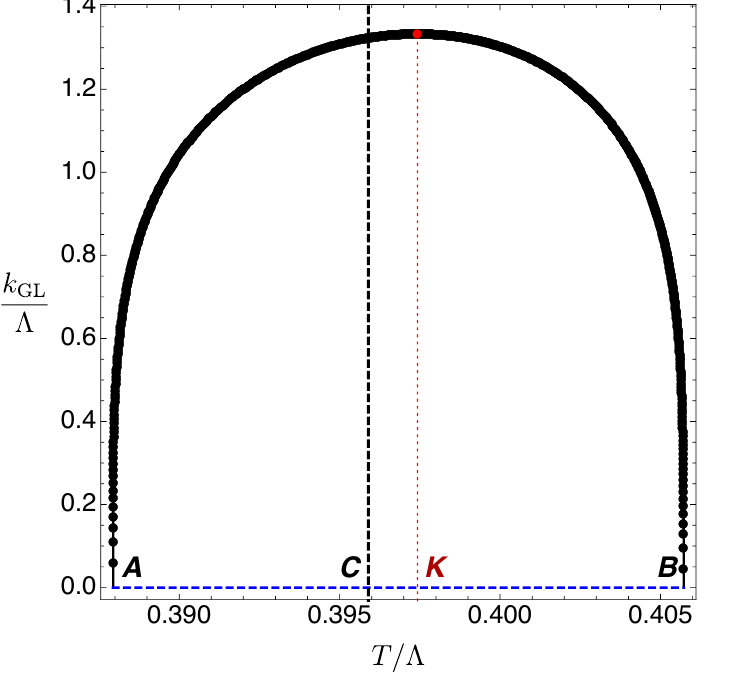
Figure 7 . Zero mode of the GL or spinodal instability, i.e. its onset wavenumber ˆ k tion of the temperature ˆ T . For reference ( ˆ T, ˆ k maximum of the instability occurs for ( ˆ T, ˆ k